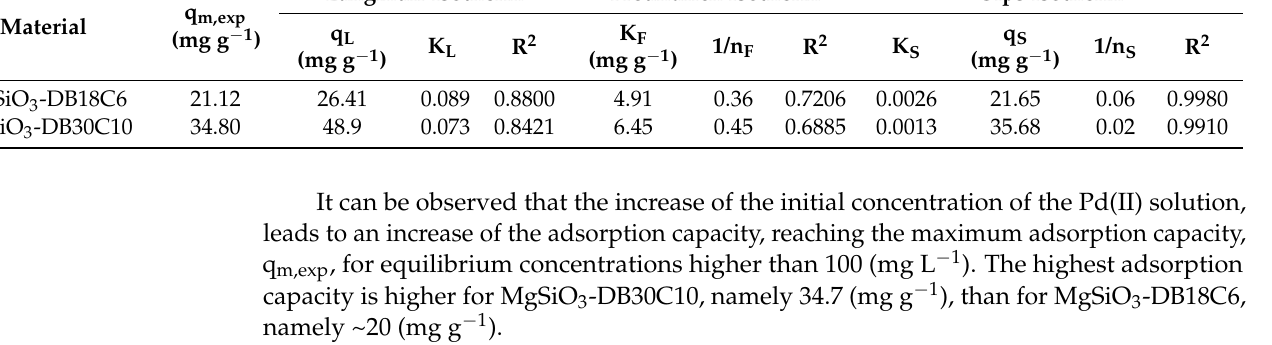
Table 4. Langmuir, Freundlich and Sips isotherm parameters for Pd(II) ions’ adsorption onto adsorbent materials. q Material